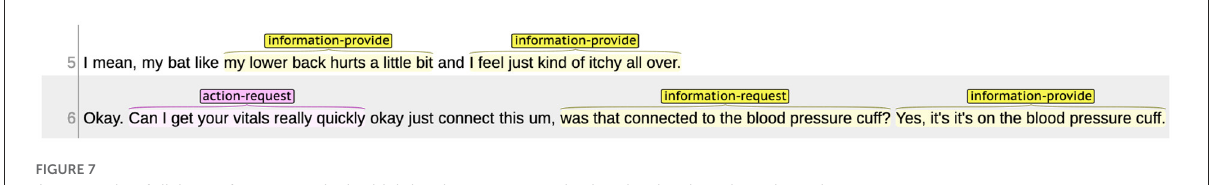
FIGURE7 An example of dialogue from scenario 1 which has been annotated using the developed tagging schema.